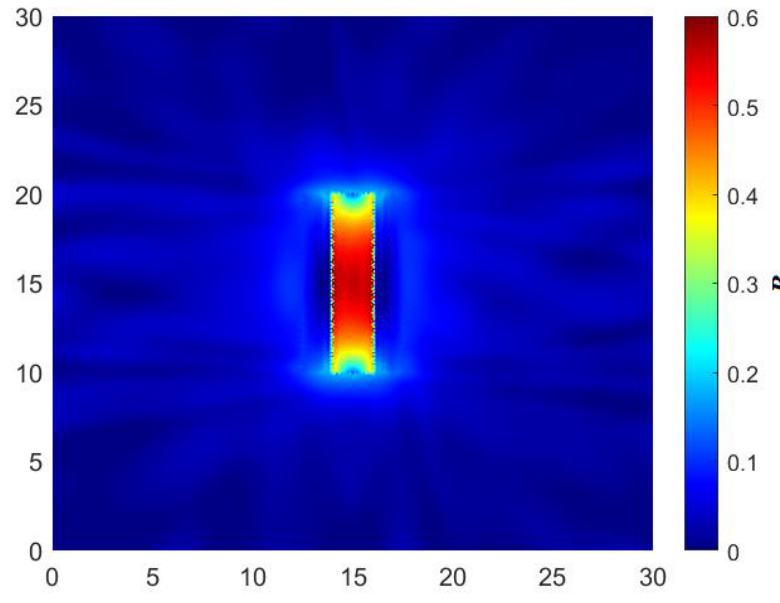
Figure 9. The neural network prediction result.